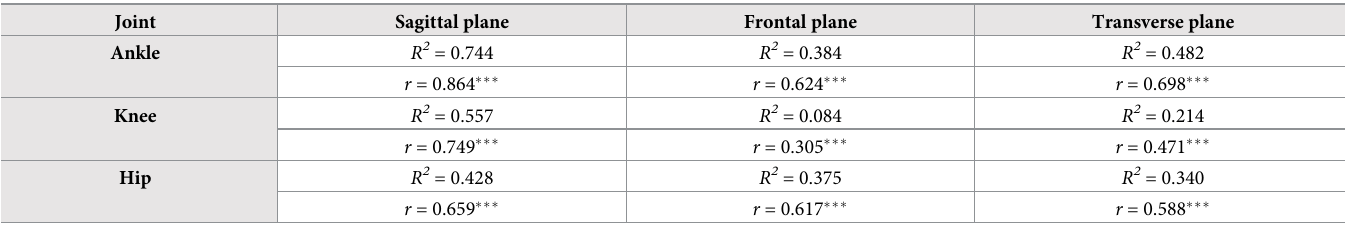
Table 1. Pearson’s correlation between minimum toe clearance (MTC) variability and the variability of lower limb joint